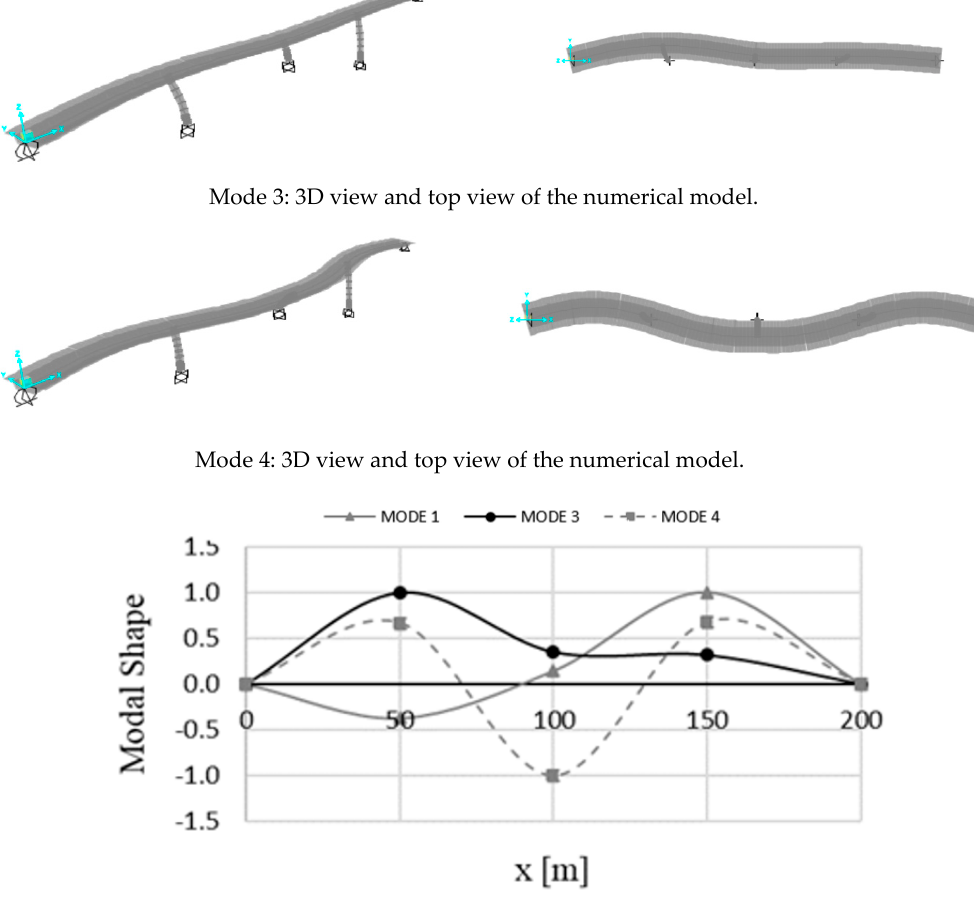
Figure 6. Bridge modal shape: most relevant modes in the transversal direction.